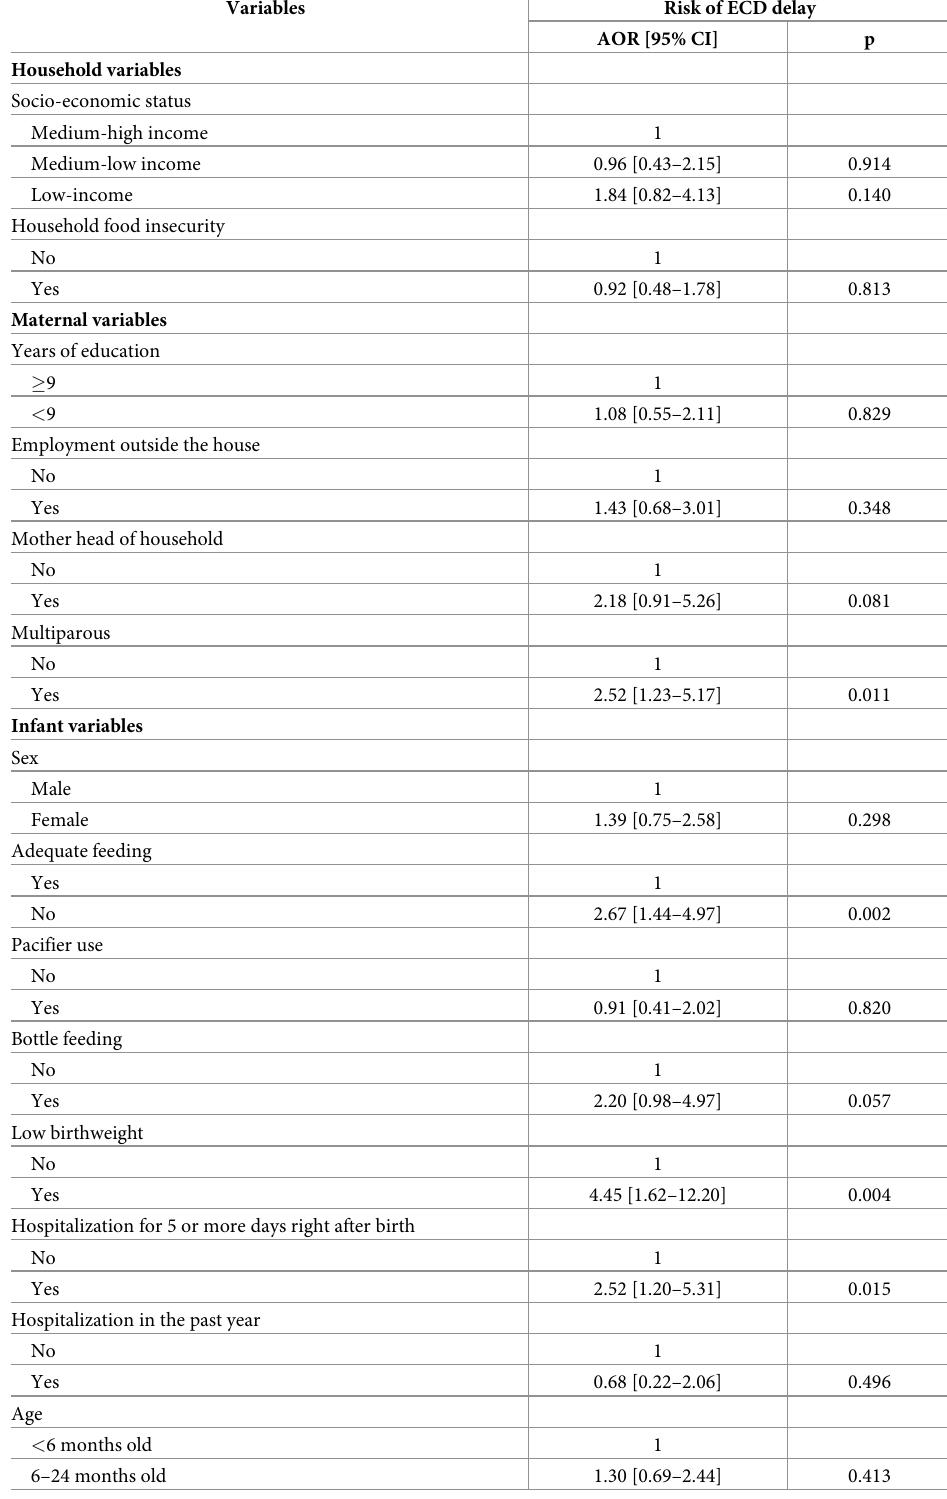
Table 3. Adjusted odds ratio (AOR) and 95% confidence interval (CI) for risk of ECD delay among children under 2 years old of adolescent and young adult mothers, Brası´lia, Brazil,